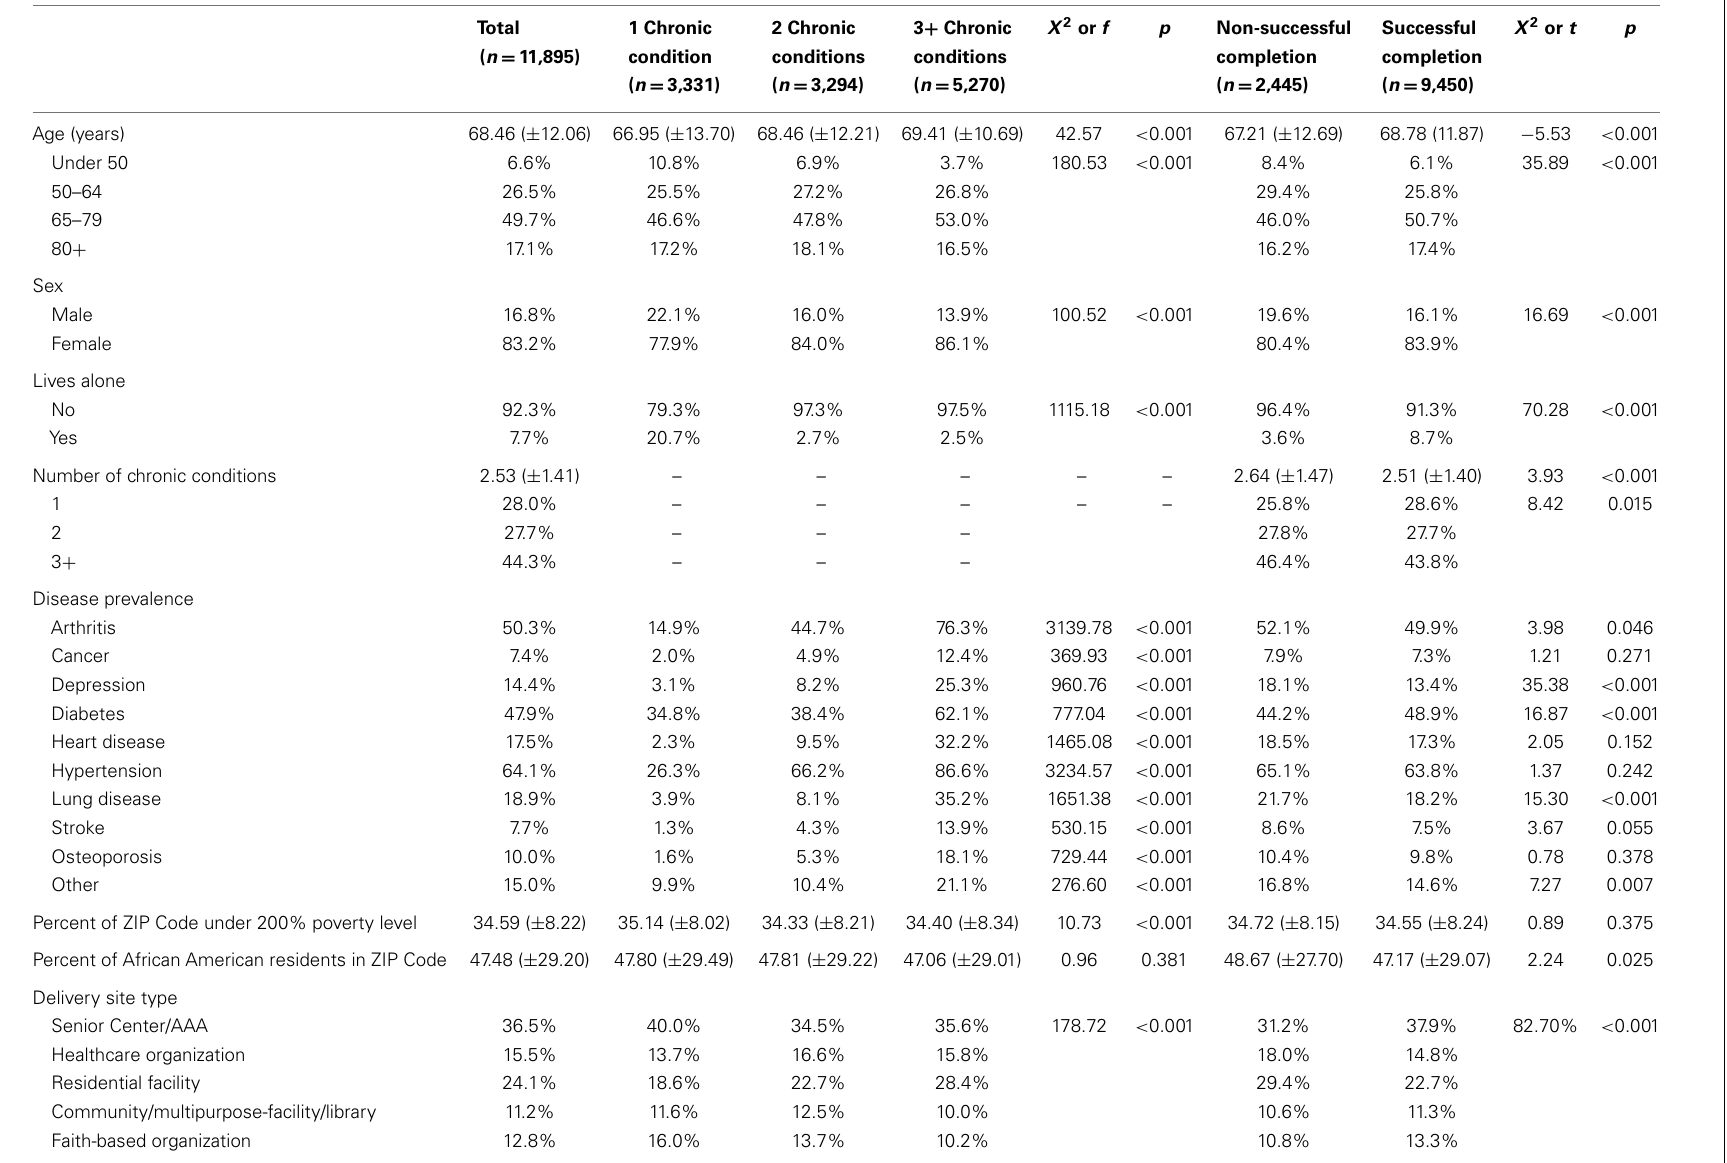
Table 1 | Sample characteristics by number of chronic conditions and CDSME program completion